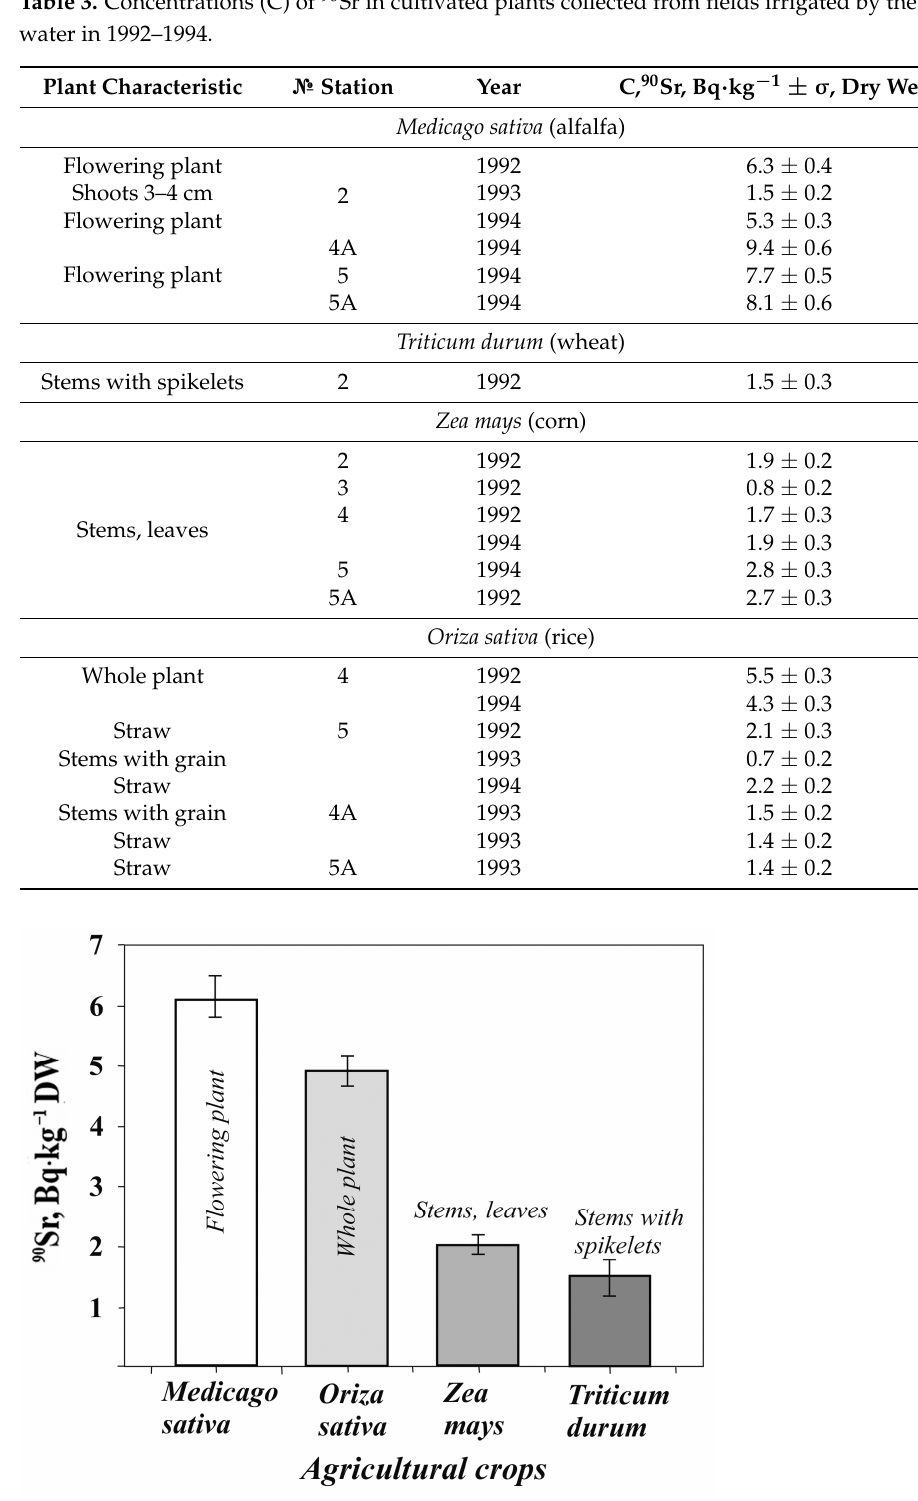
Figure 8. Average concentrations of 90 Sr in agricultural plants grown in irrigated fields along the NCC (1992–1995). Table 4. Transfer factors (TF) of 90 Sr from irrigated soils to agricultural plants.